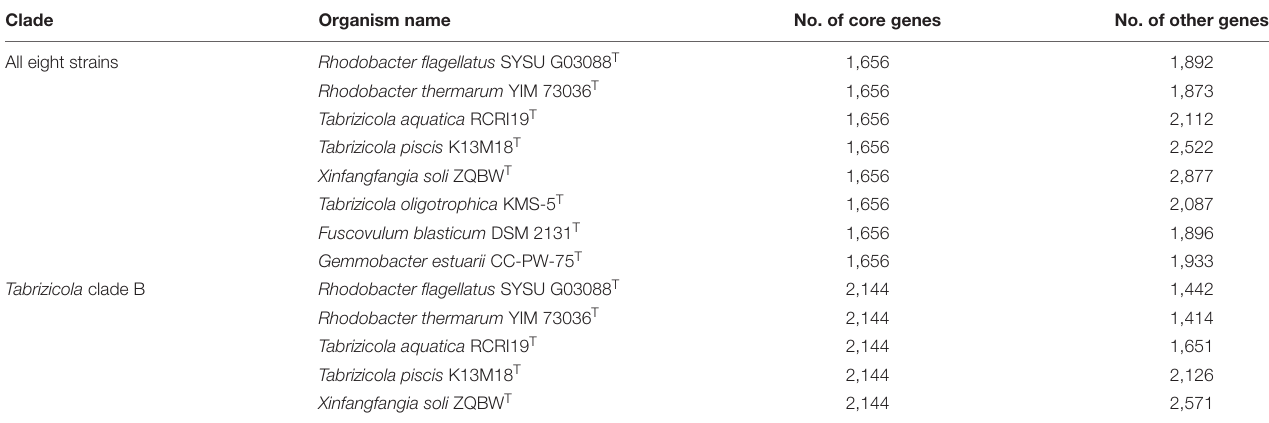
TABLE 5 | Pan-genomic analysis of Tabrizicola clade B and the related